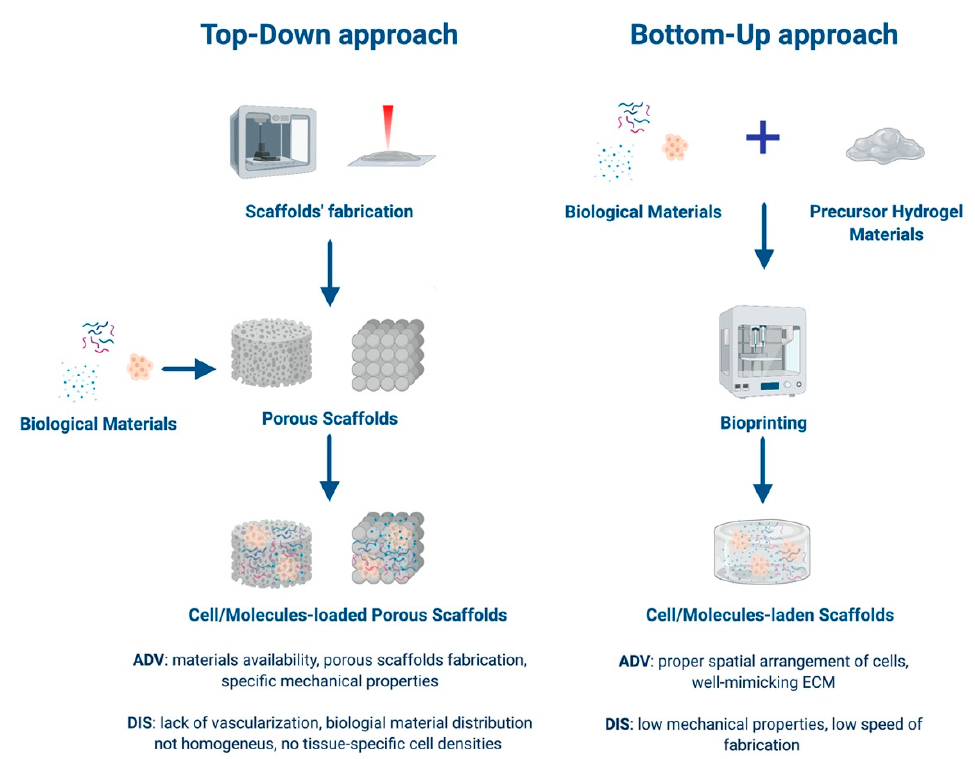
Figure 1. Schematization of the approaches applied in additive manufacturing (AM) techniques. On the left, the top-down approach is shown, which employs AM techniques to produce 3-D scaffolds with the appropriate architecture to guide the formation of the desired tissue. In this case, living cells are seeded on or within the porous 3-D structures. On the right, the bottom-up approach is described, where scaffolding materials, cells, and sometimes also bioactive factors are assembled together, forming building units of several shapes and sizes. Advantages (ADV) and disadvantages (DIS) of each technique are also reported. Made in ©BioRender—biorender.com.